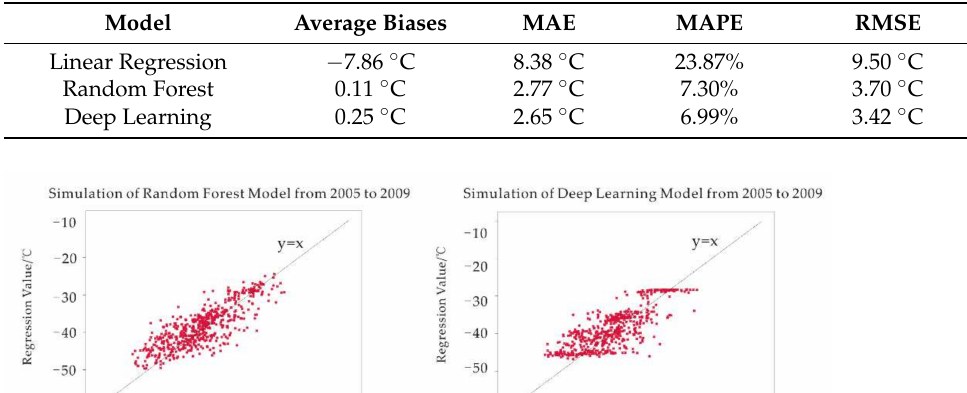
Figure 8. Comparison of the deviation degree between the simulation and the true value. Table 4. The assessment of the models through the test data.